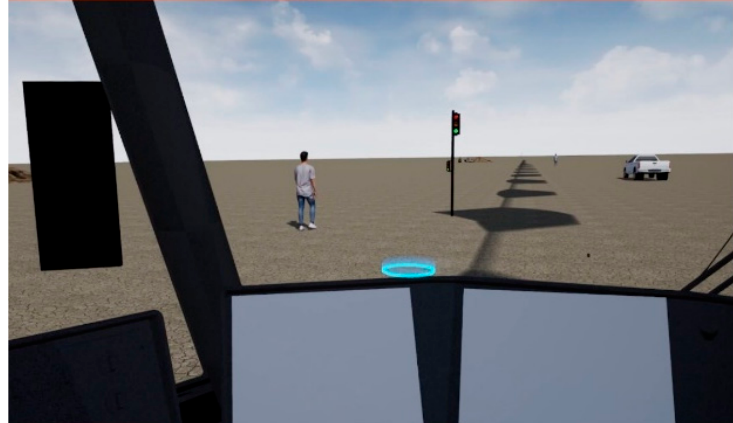
Figure 9. View from the cabin with left-hand A-pillar and mirror.